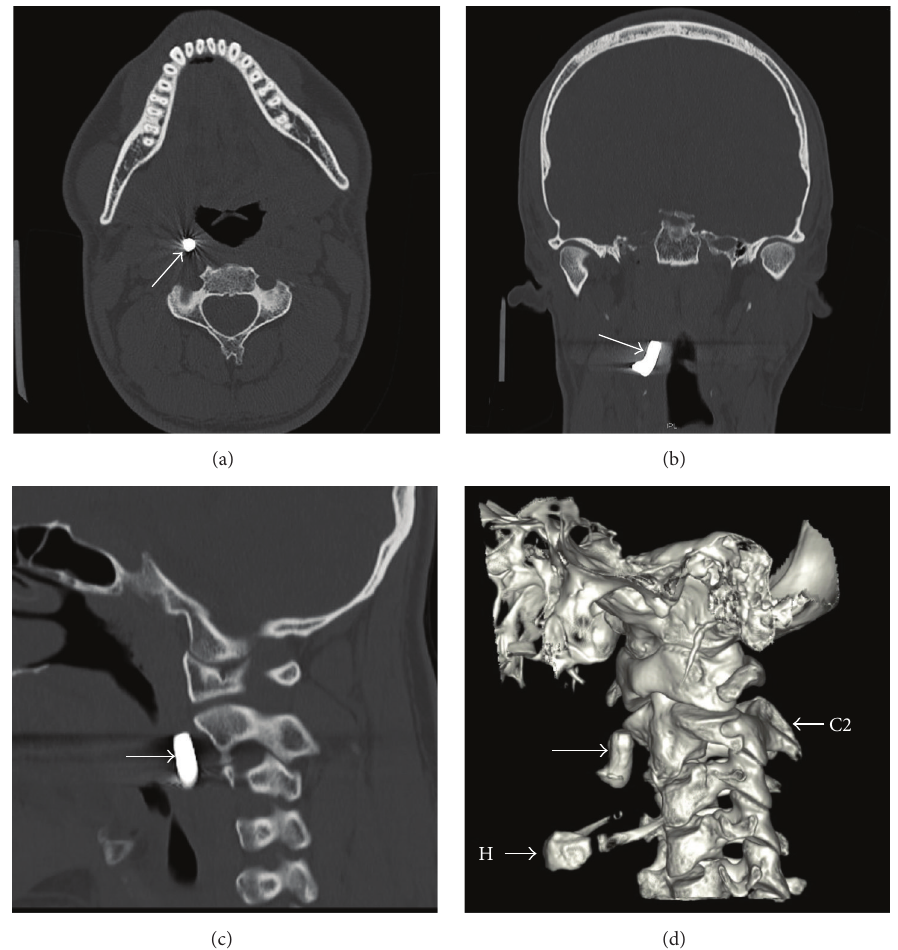
Figure 1: Axial (a), coronal (b), and sagittal (c) CT scans of the head and neck region showing the projectile in the parapharyngeal space, just ventrally to the longus colli muscle and medially to the carotid sheath. (d) A three-dimensional reconstruction (left lateral view). Arrow: projectile, H: hyoid, and C2: vertebra